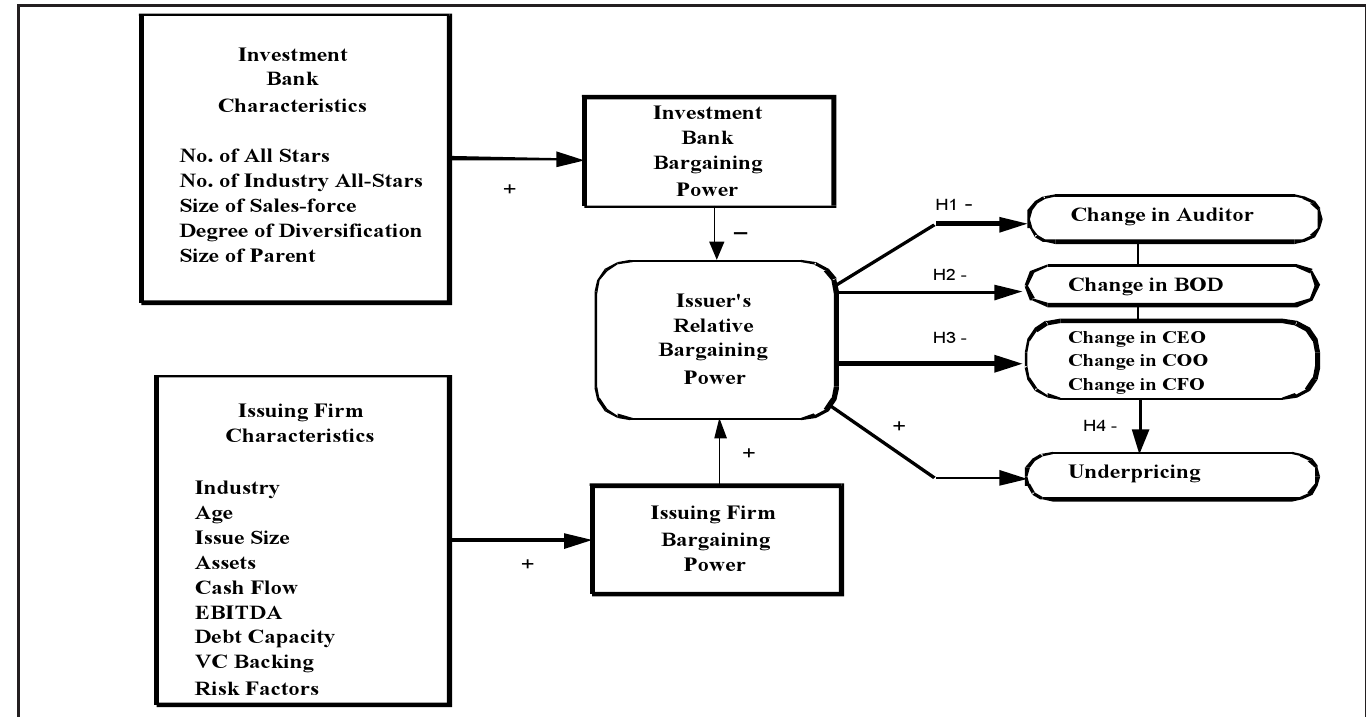
Figure 1. Model of Pre-IPO Organizational Change and effect on Underpricing